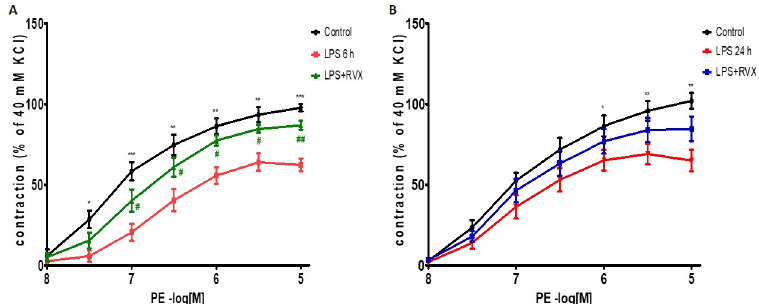
Fig 4. Role of RVX on the vasoreactivity of aortic rings obtained from A) rats sacrificed 6 hours post LPS and B) rats sacrificed 24 hours post LPS to PE-induced contractions. Comparisons of vascular reactivity to PE in aortic rings from RVX- or non-treated LPS rats and non-treated control rats. � P < 0.05, �� P < 0.01 and ��� P < 0.001 indicates statistical significance (Two-Way ANOVA followed Bonferroni correction) vs. control; #P < 0.05 and ##P < 0.01 indicates values significantly different (Two-Way ANOVA followed Bonferroni correction) vs. LPS. Values are expressed as the ± SEM (n = 6).